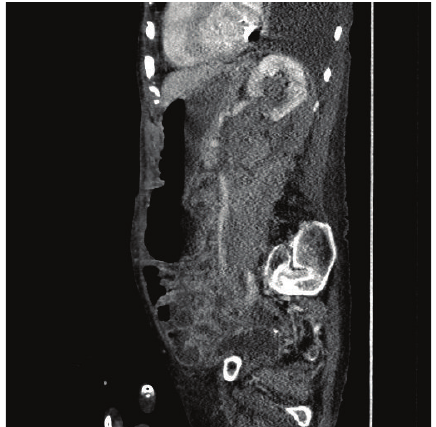
Figure 5: Split bolus contrast CT KUB: sagittal